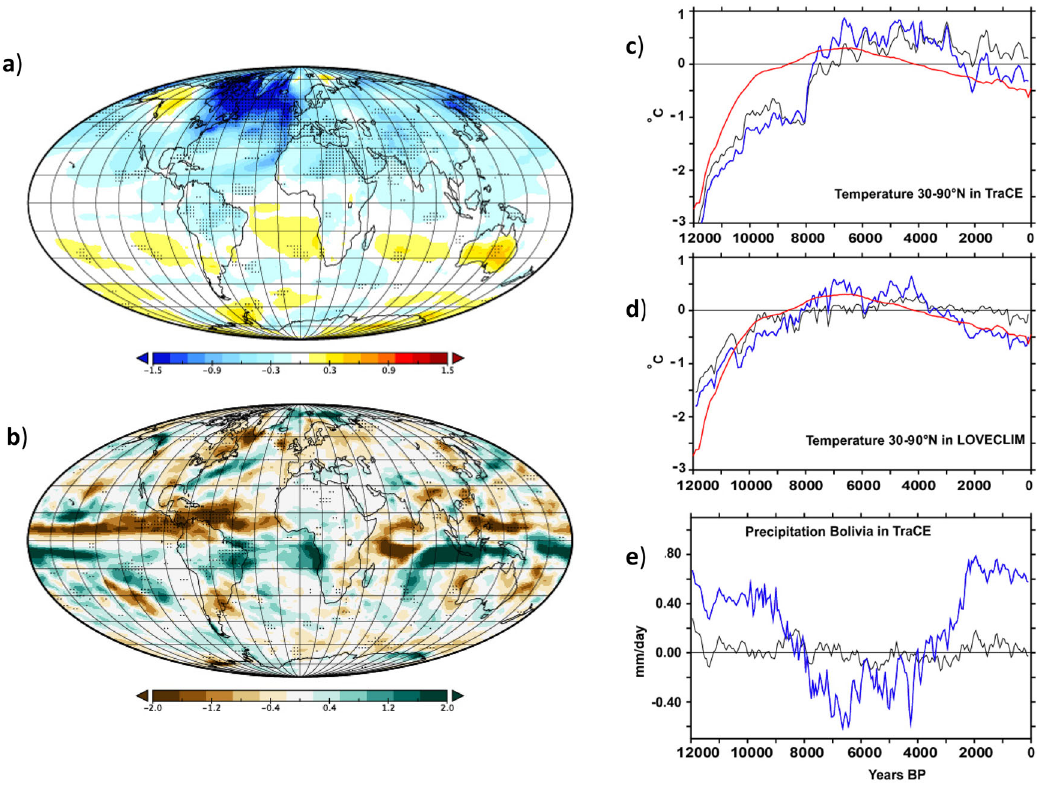
Fig. 4 Temperature and precipitation changes related to AMOC changes. a Ensemble mean surface temperature change (annual mean value in °C) of fi ve models, showing the difference between hosing and control simulations (blue color shows colder temperatures compared to the control simulation and green color higher precipitations). The stippling indicates where all the model simulations exhibit the same sign of changes. This pattern of temperature change is mainly related to reduced AMOC strength. b Same as ( a ) but for precipitation (mm/d). c , d 30 – 90°N AMOC adjusted Holocene temperature changes (blue curves) based on the semi-empirical linear model for TraCE simulation and LOVECLIM simulation (black curves) respectively as compared with temperature reconstruction from ref. 45 (red curve). The standard deviation used is 1.2 Sv for the AMOC. e same as ( c , d ) but for precipitation in the Charquini region (tropical Andes of Bolivia 16°S, 68°W). A 100-year running mean has been applied to the time series in ( c – e